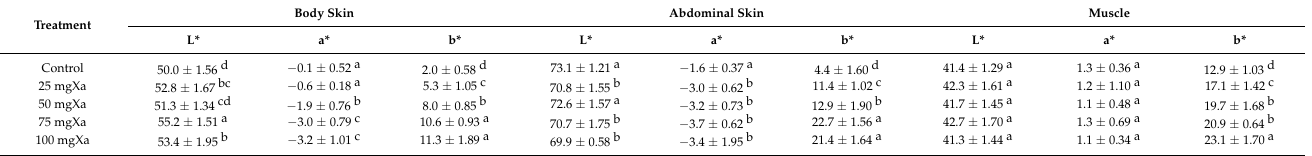
Table 6. L*, a*, b* for body skin, abdominal skin, and muscle of bighead catfish fed dietary Xa for 4